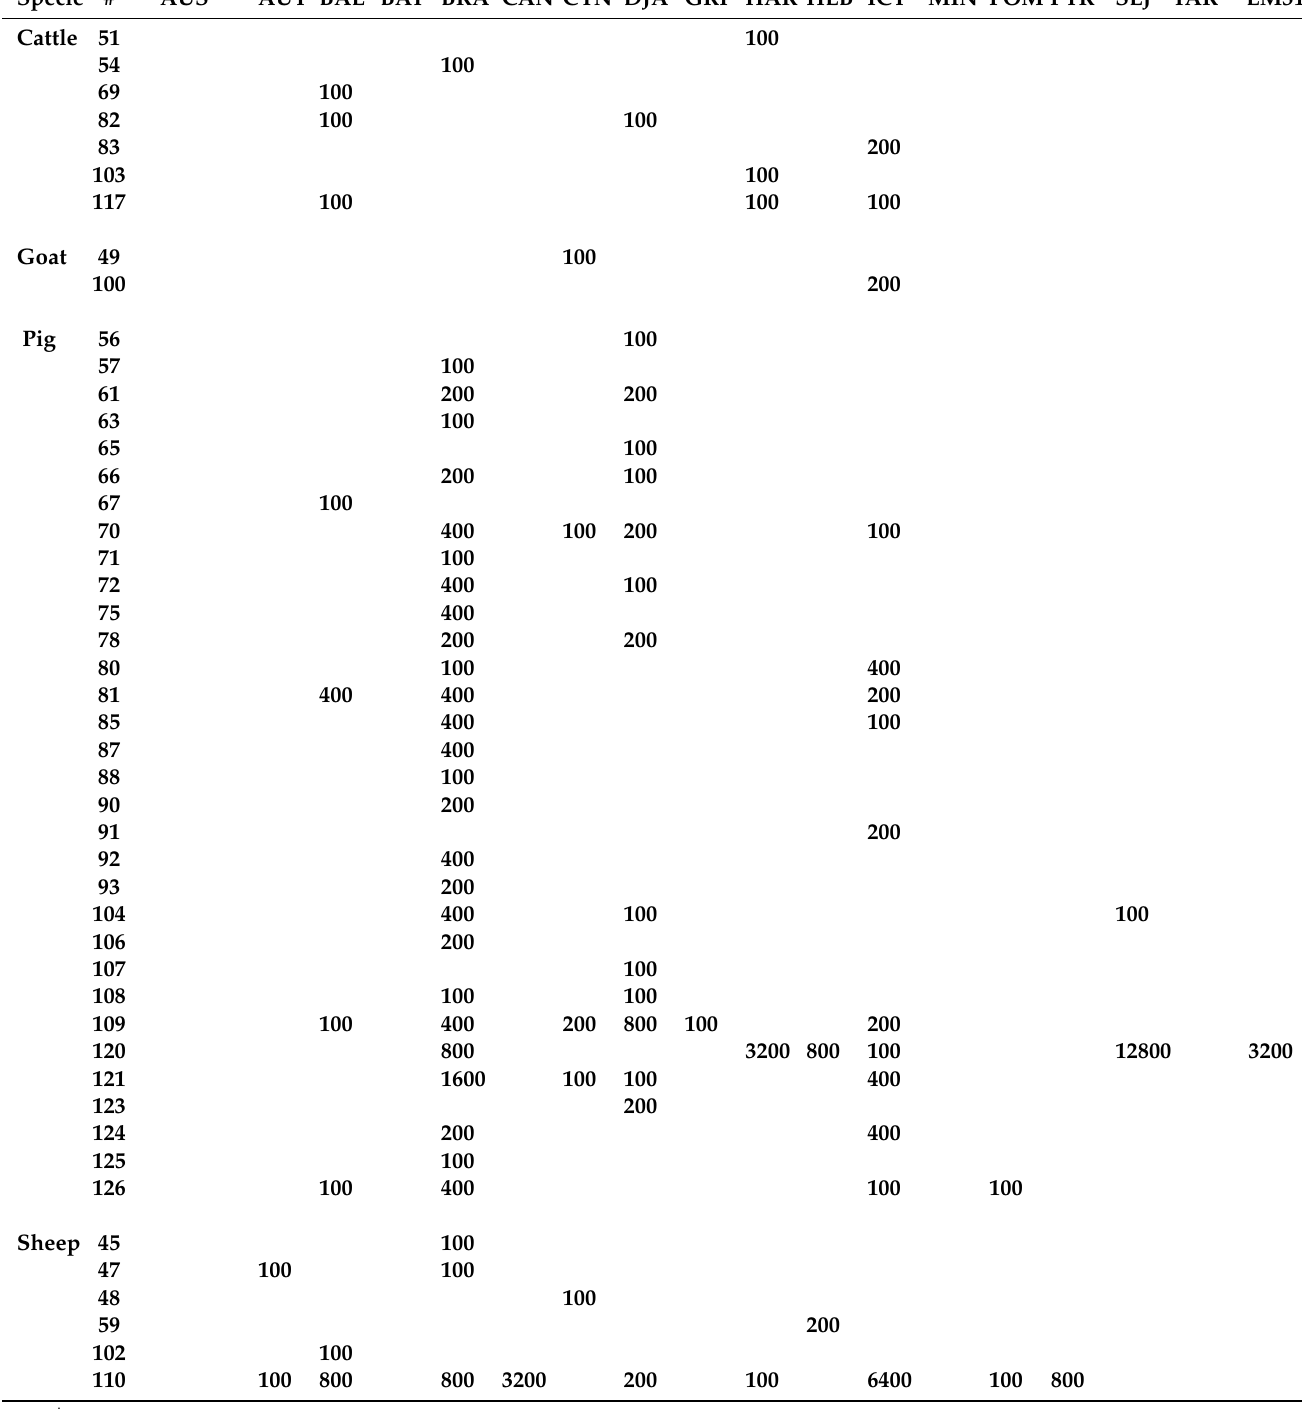
Table A2. Titer and associated serovar(s) (n=47/125) of microscopic agglutination test (MAT) positive livestock serum samples in St. Croix, U.S. Virgin